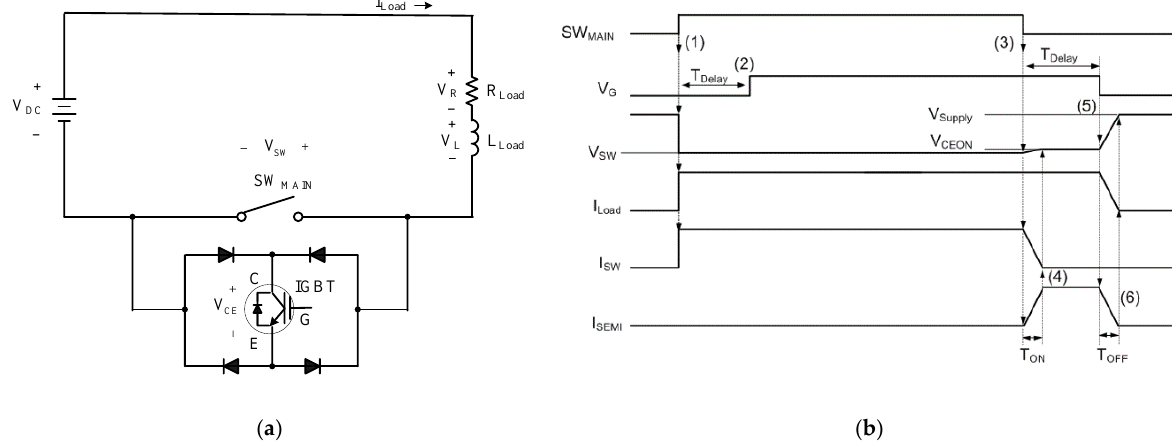
Figure 2. Concept of the proposed LVDC hybrid circuit breaker; ( a ) power circuit concept, ( b ) sequence of operations.